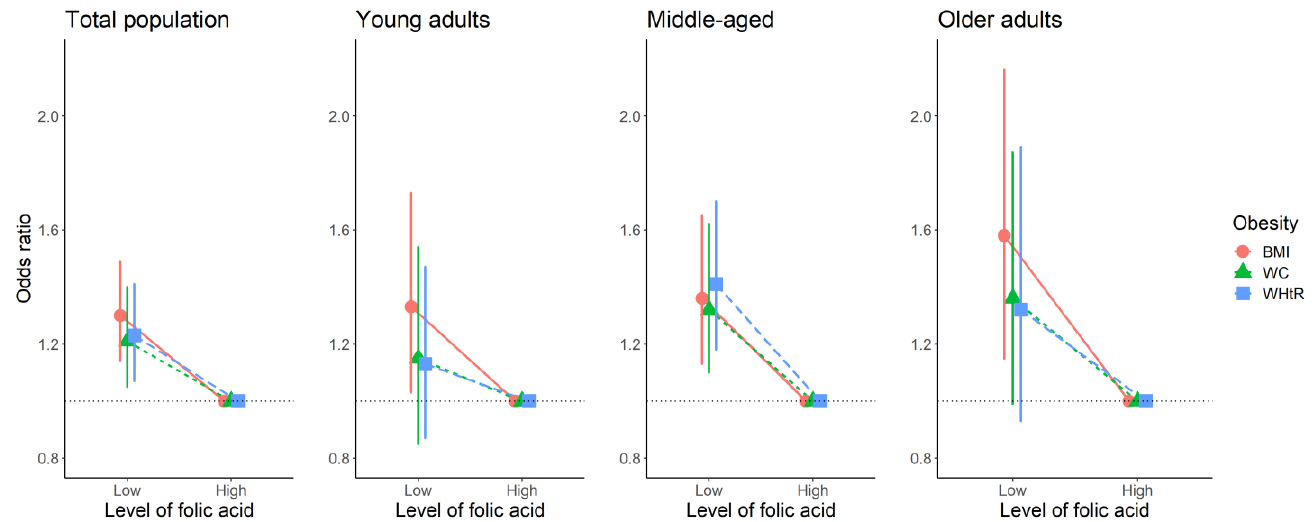
Figure 2. The association between binary of folic acid and BMI, WC, WHtR, and ABSI in each age group using multivariate logistic regression. Abbreviations: BMI, body mass index; WC, waist circumference; WHtR, waist-to-height ratio.